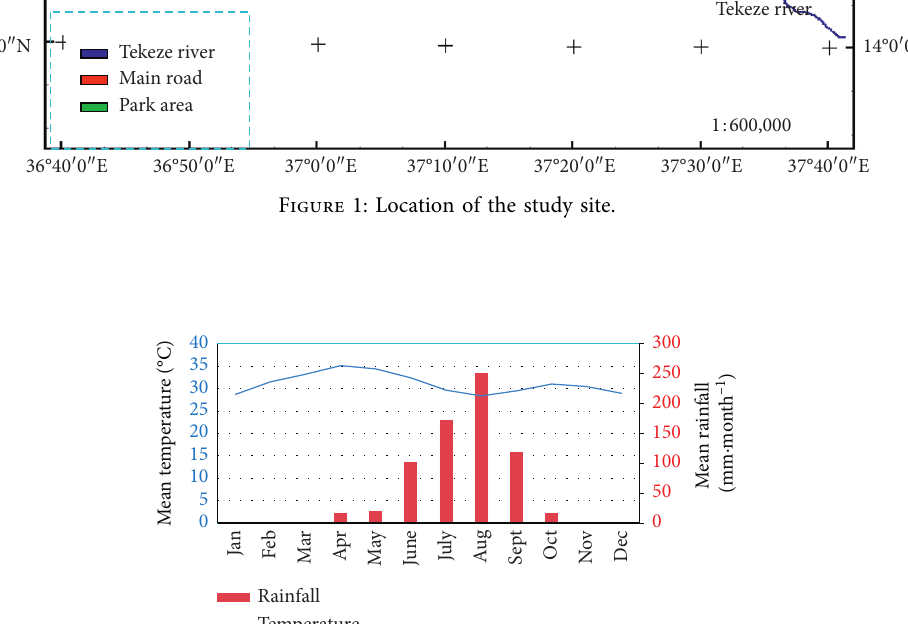
Figure 2: Mean monthly rainfall (mm · month − 1 ) and temperature ( ° C) of Humera and Shiraro Meteorological Center from 1966 to 2016 (Ethiopian National Meteorological Agency